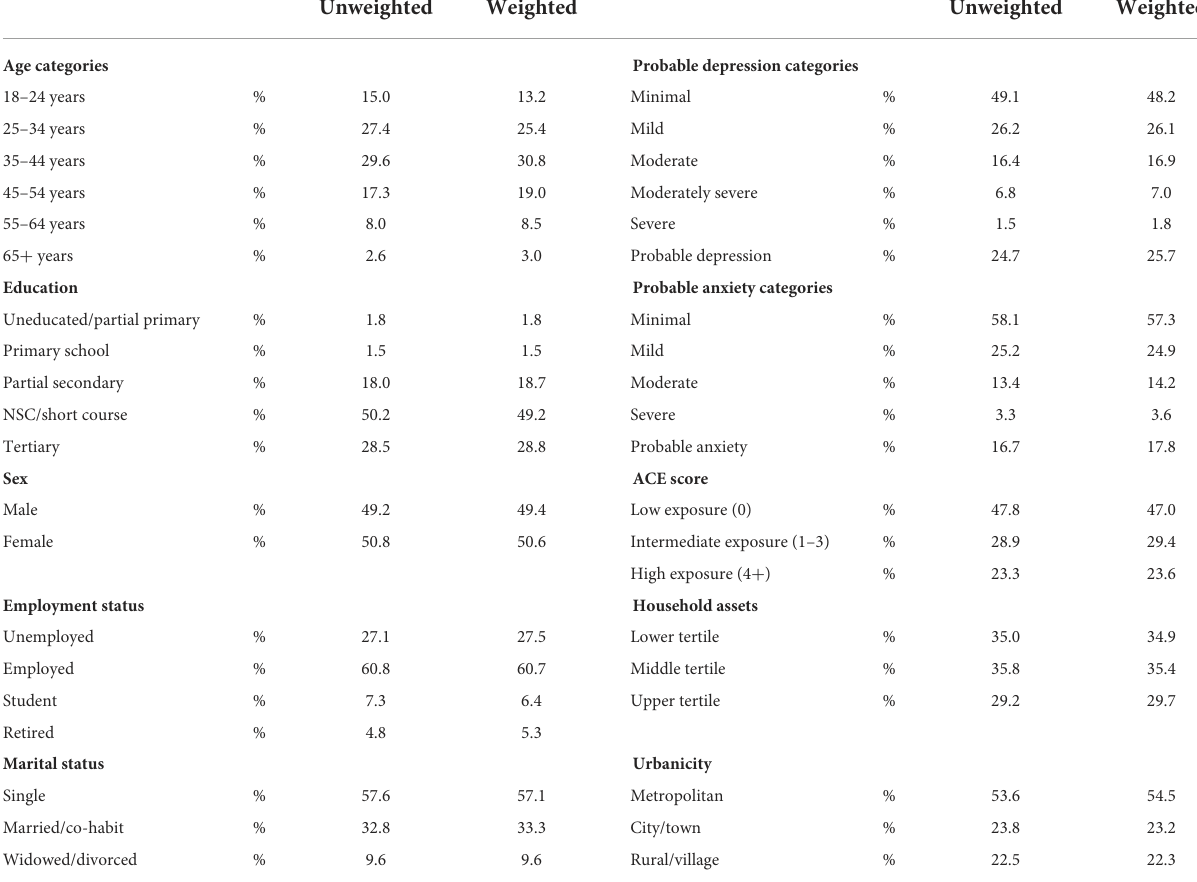
TABLE 1 General descriptives of the South African survey respondents ( n =